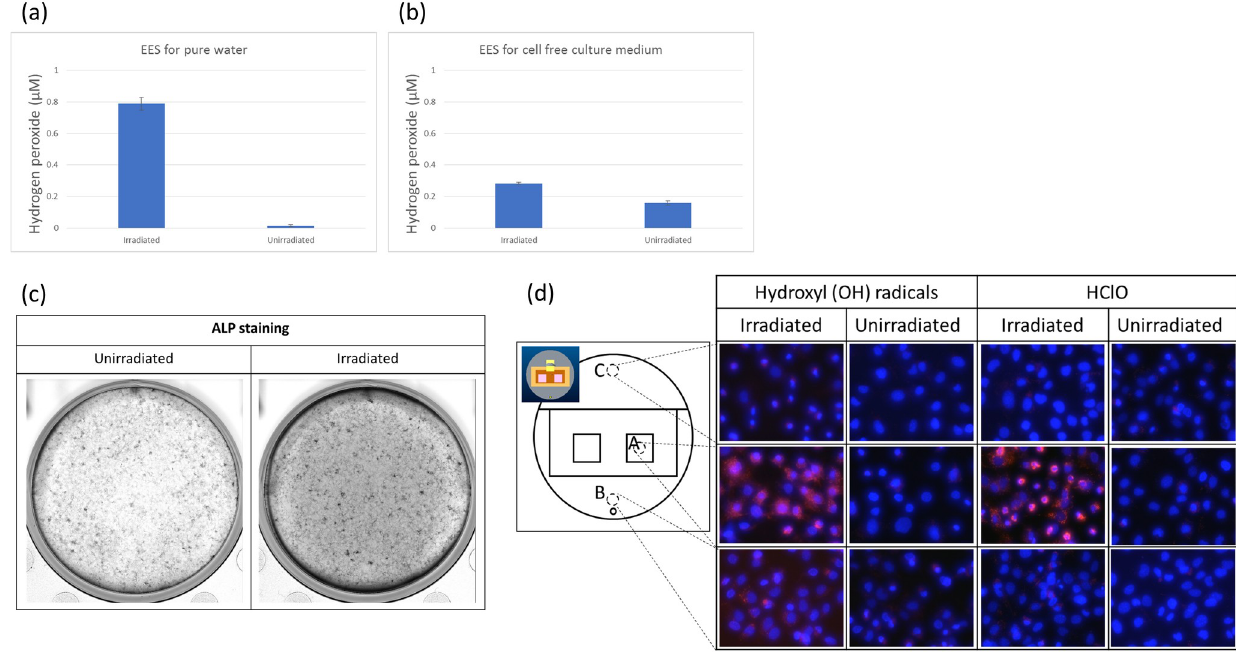
Fig 2. ROS production by EES. (a) H 2 O 2 concentration in pure water with or without EES treatment. Vd and Ie were fixed at 15.0 V and 2.3 μ A, respectively, and irradiation time was 1 min. The data points represent the mean value ± SD (n = 3). (b) An experiment similar to that in (a) was conducted for culture medium without cells. (c) Alkaline phosphatase staining of the MC3T3-E1 cells with no stimulation and subjected to EES (Vd and Ie were fixed at 15.0 V and 2.3 μ A respectively), for 4 days. (d) Images of fluorescent compounds produced by reaction with intracellularly induced HO � and HClO (both are red) by EES. A: immediately under the irradiation position, B: just beside the collector electrode, C: far away from the irradiation position. Nuclei were stained with DAPI (blue).